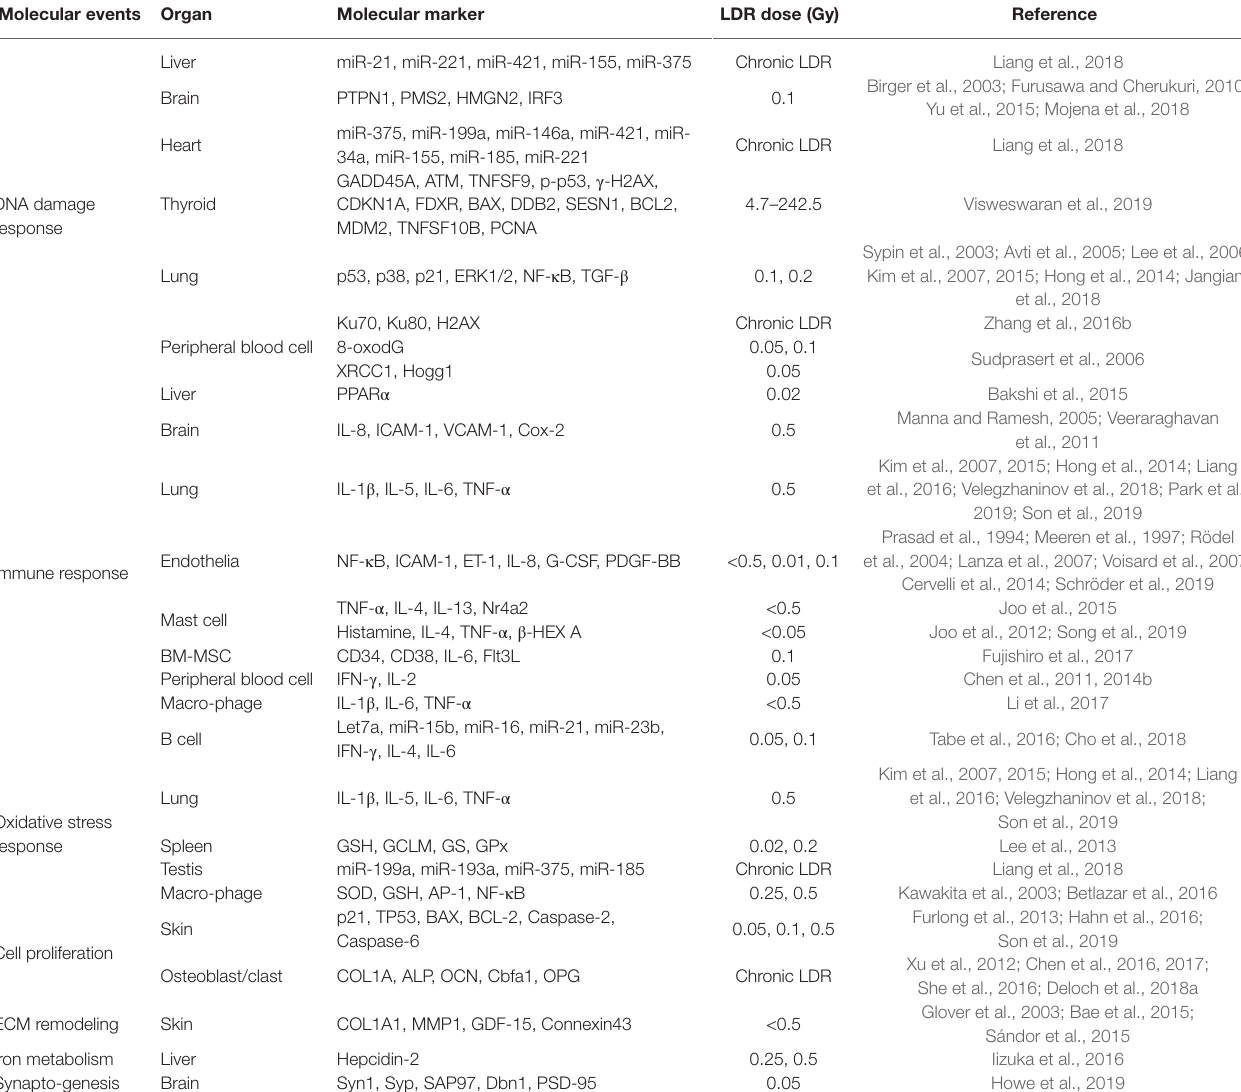
TABLE 1 | Organ-specific molecular events and the markers regulated by LDR exposure. Molecular events